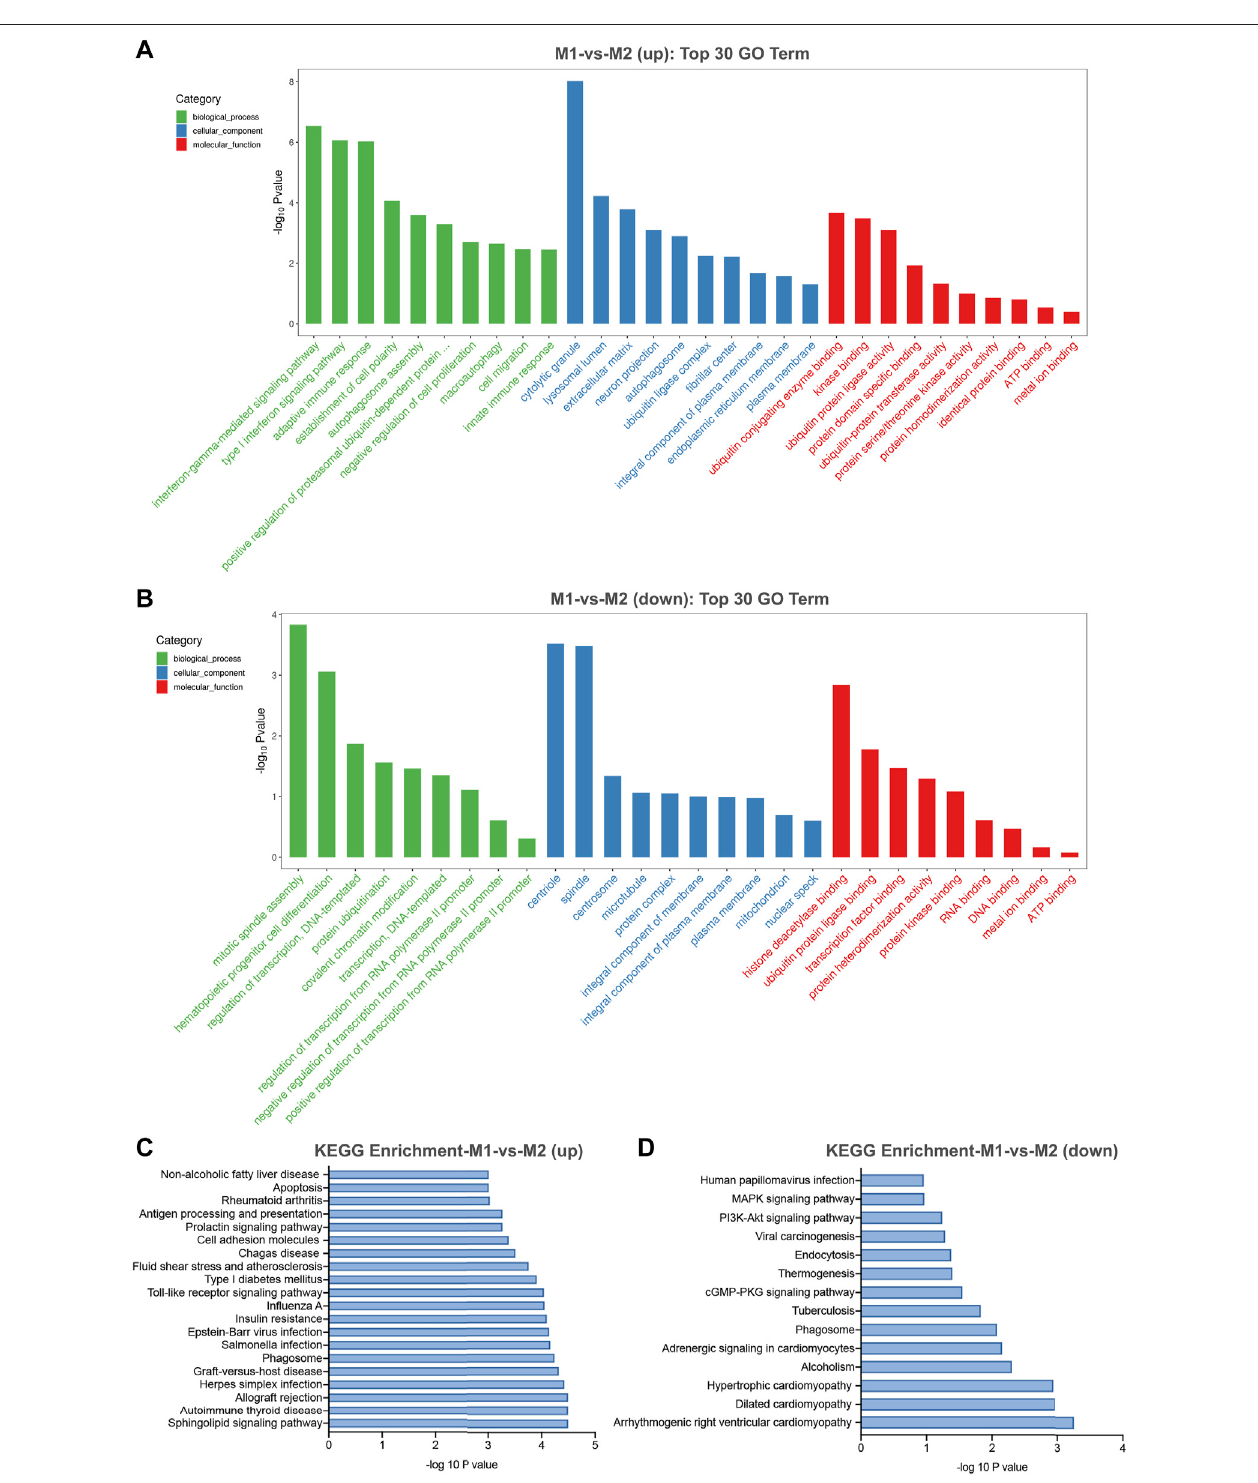
FIGURE5| GOandKEGGpathway analysisfordifferentially expressed circRNAsinM1macrophages. (A) Thetop30GOtermsinbiologicalprocess (BP),cellular component (CC) and molecular function (MF) categories for up-regulated circRNAs. (B) The top 30 GO terms in BP, CC and MF categories for down-regulated circRNAs. (C) The top 20 enriched signi fi cant enriched pathways for up-regulated circRNAs. (D) The top 14 enriched KEGG pathways for down-regulated circRNAs.